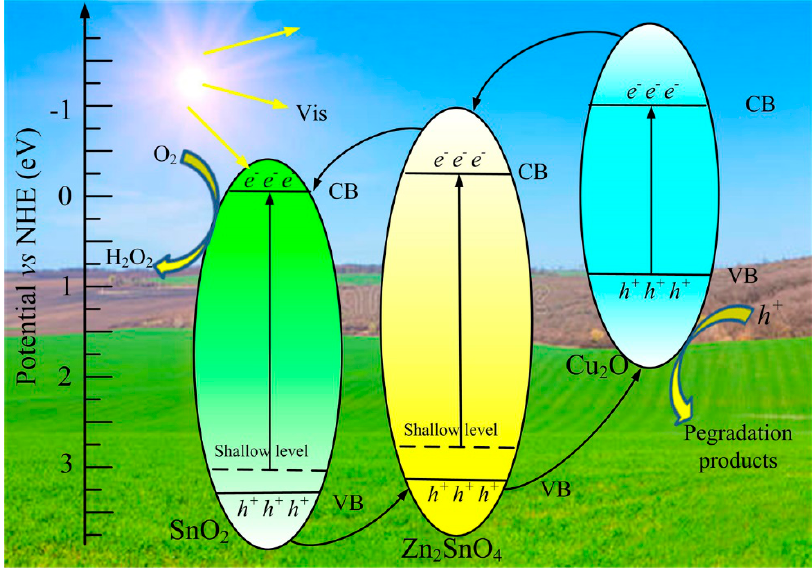
Figure 10. Schematic diagram of the charge transfer over the ZSC hybrids system under visible-light Schematic diagram of the charge transfer over the ZSC hybrids system irradiation.